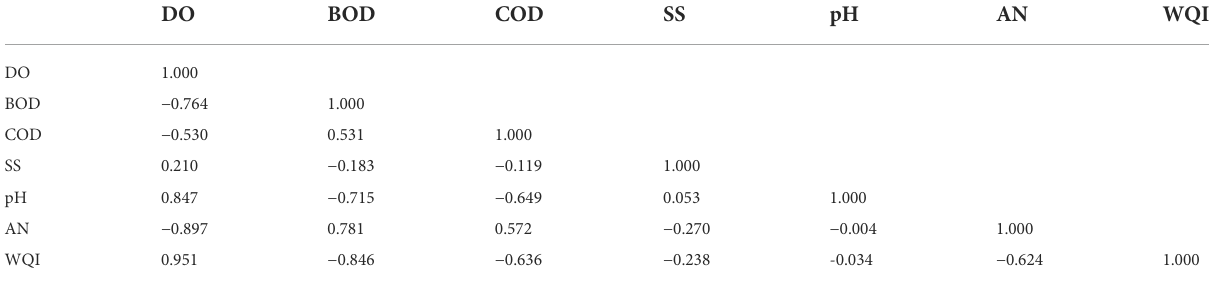
TABLE 6 Correlation matrix between selected water quality parameters and the WQI.